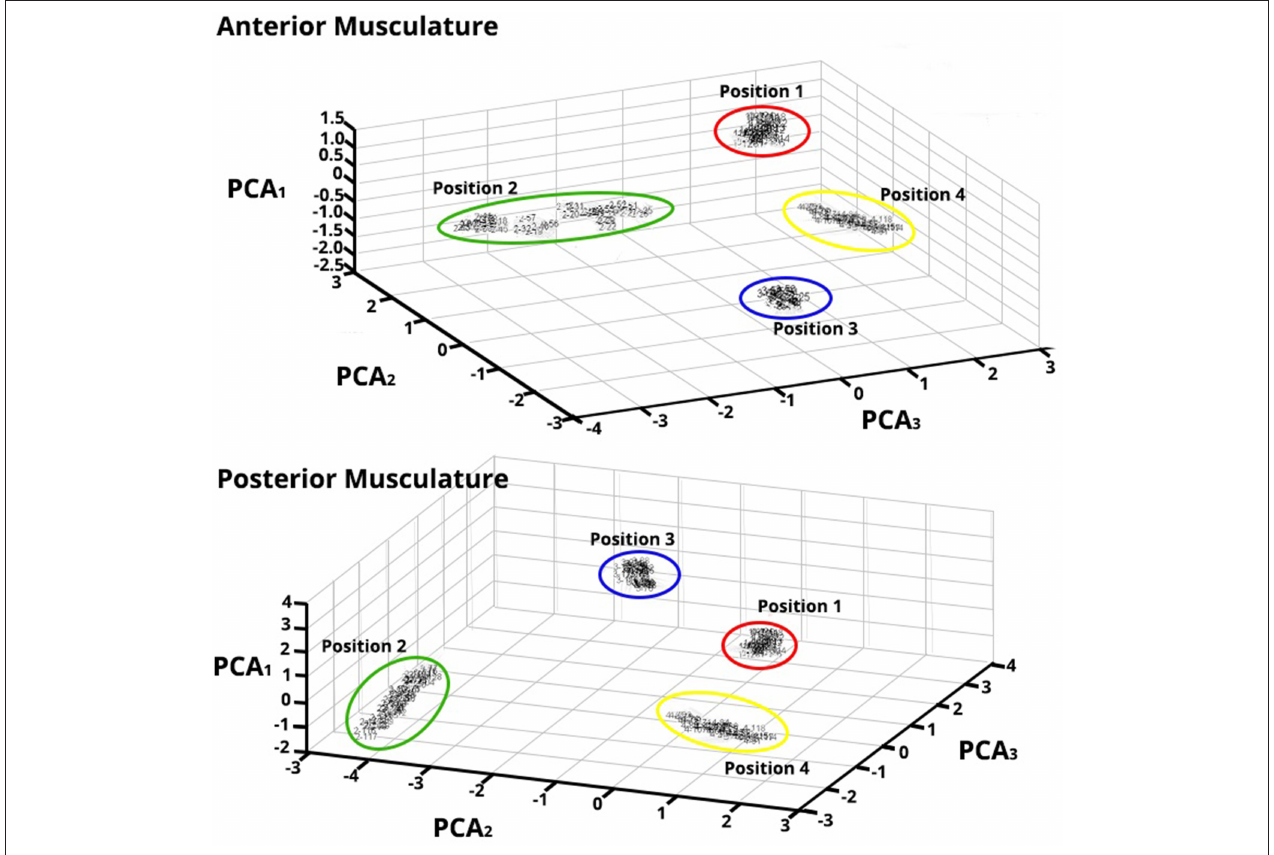
FIGURE 7 | Principal Component Analysis (PCA) for Feature Vectors (FV) after Data Were Trained applying SOFM—Forearm Flexor Muscles (top) and Extensor Muscles (bottom) —PCA of the FV after SOFMs were applied to the trained data for a randomly chosen subject. As depicted, each color represents each position that the thumb was opposed to. The resulting PC conversion shows tight clusters; this clustering also reflects the wide distance between neighborhoods. Note that the PCA1 axes are of different amplitude highlighting the different magnitude responses in each